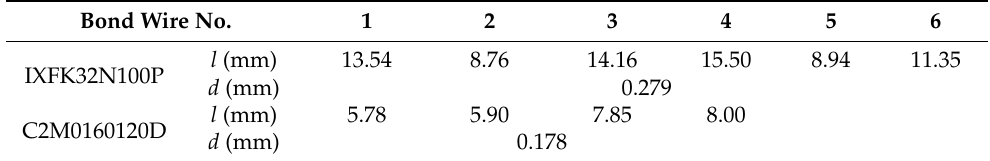
Table 1. Bond wire dimension for MOSFETs.